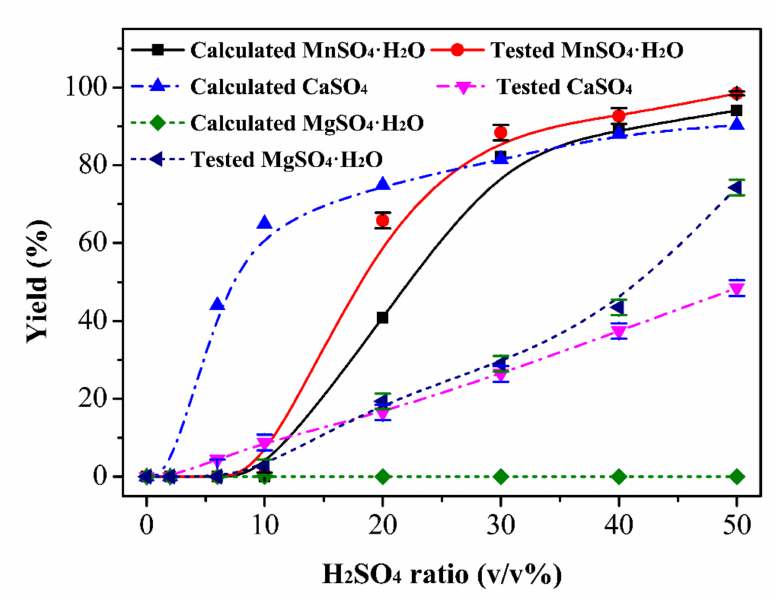
Figure 3. The calculated and tested yield of different components of industrial MnSO 4 solution with the addition ratio of H 2 SO 4 .